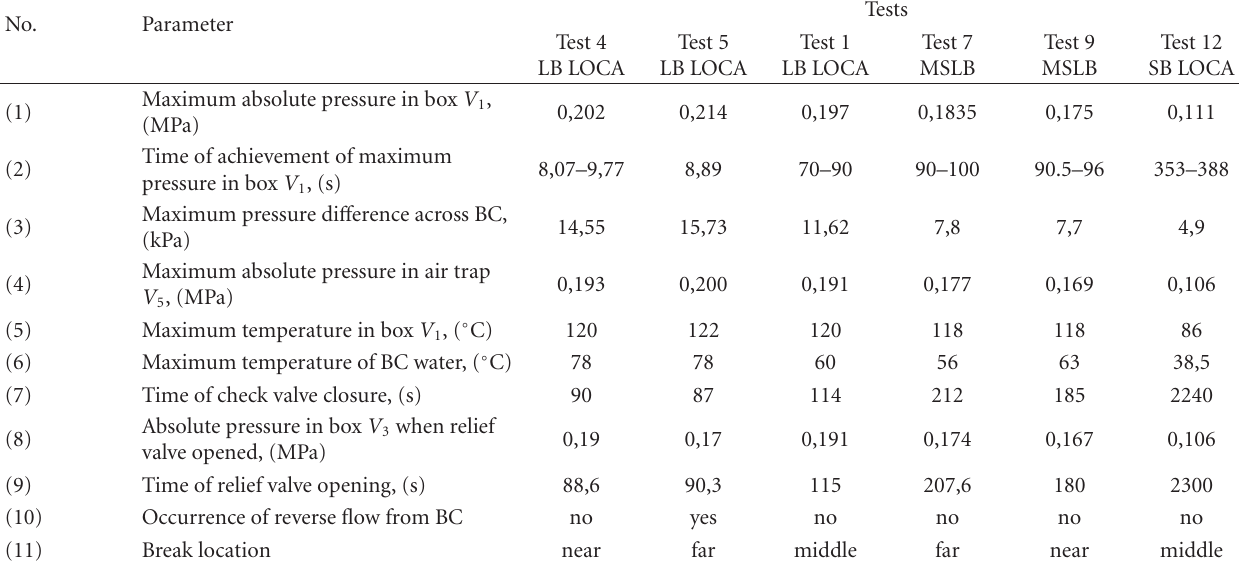
Table 7: Summary of main experimental